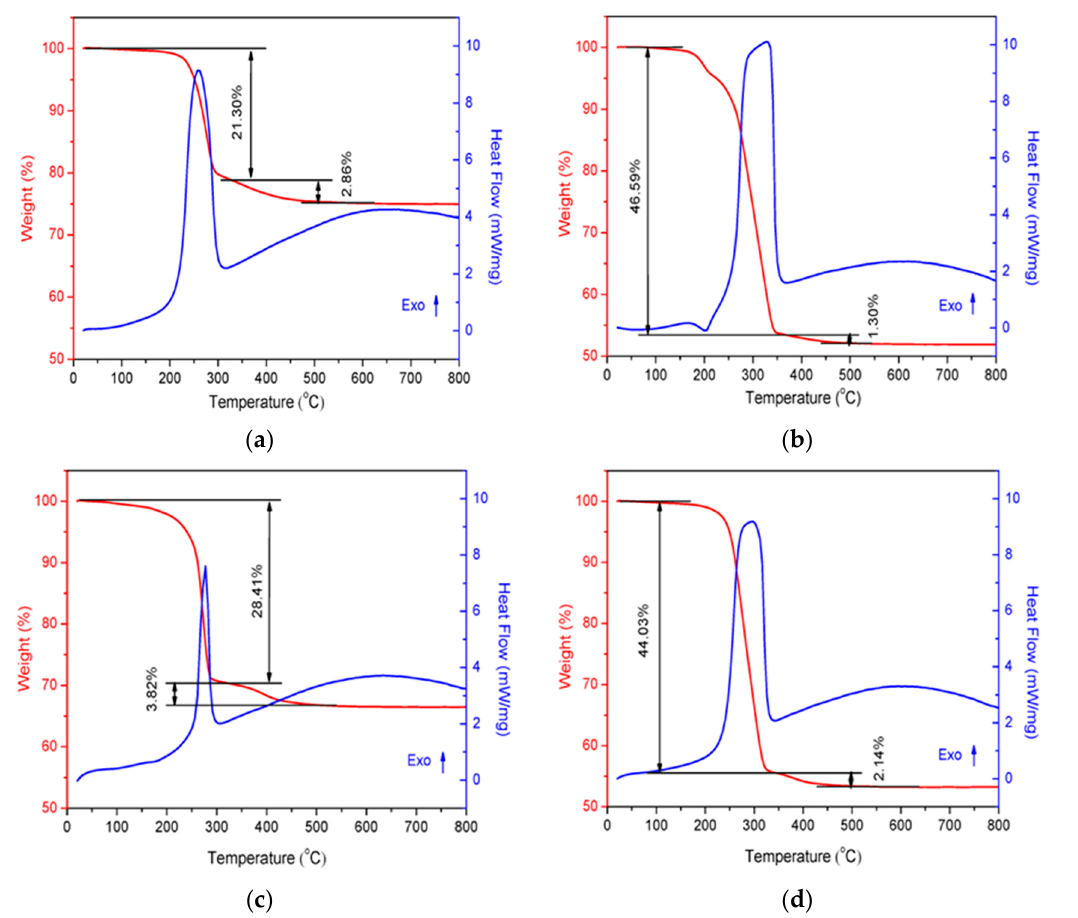
Figure 1. TG–DSC curves of the CoCe–X precursors: ( a ) CoCe–MA; ( b ) CoCe–CA; ( c ) CoCe–GA; and ( d ) CoCe–TA.